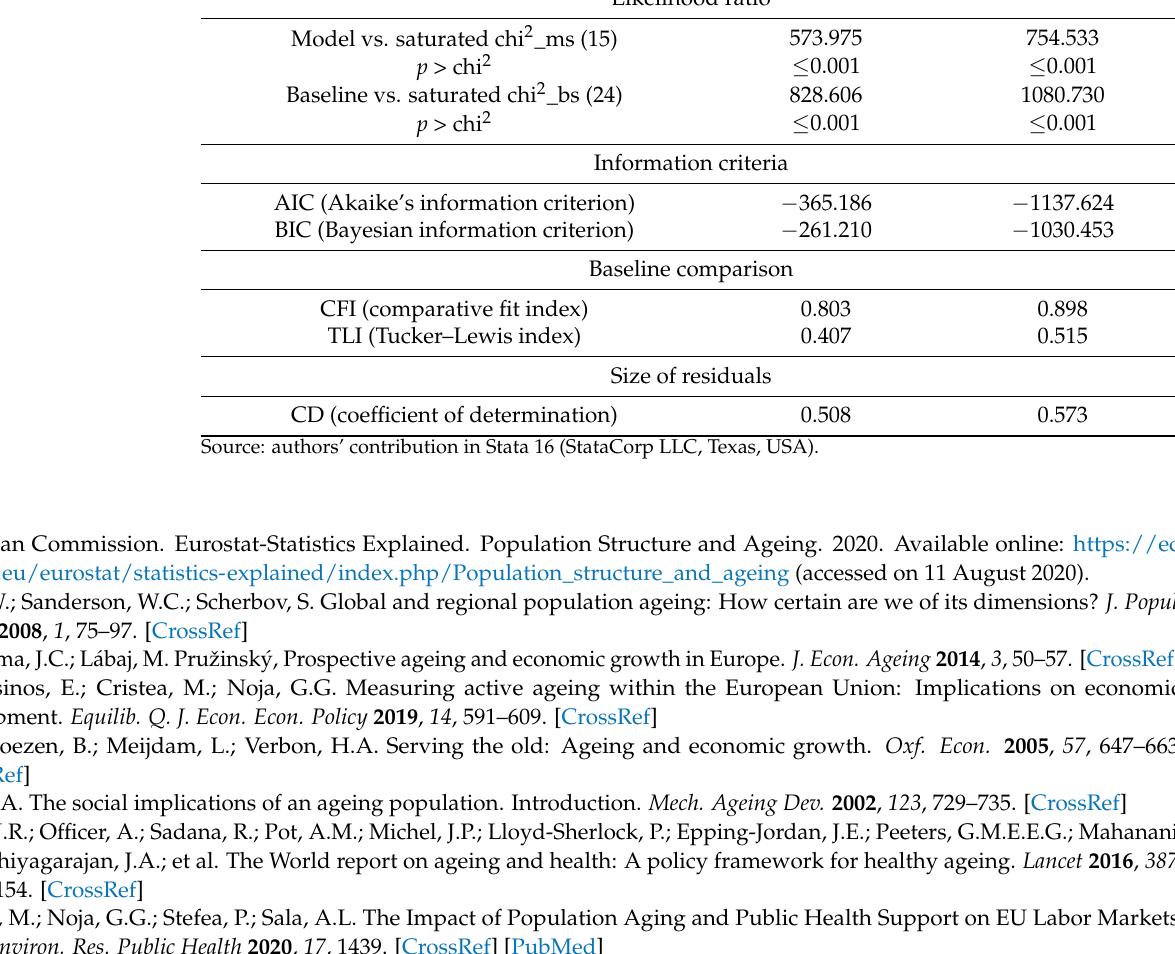
Table A5. Goodness-of-fit tests for the SEM models, 1995–2017.